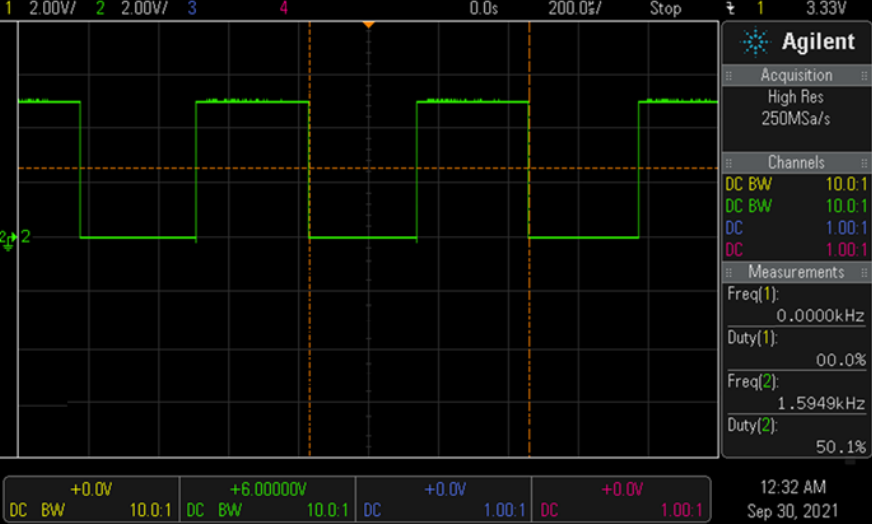
Figure 10. Result of simulating the waveform associated with detecting the clip.